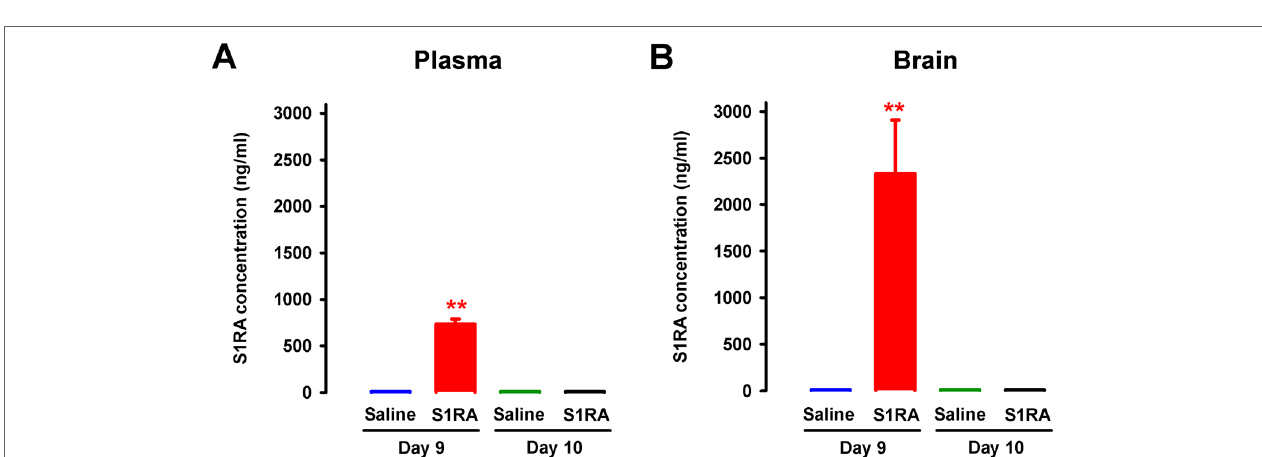
FIGURE 12 | Concentrations of S1RA in plasma and brain tissue after its repeated administration in female WT. The levels of S1RA were measured by high- performance liquid chromatography–triple quadrupole mass spectrometry (HPLC-MS/MS) in plasma (A) and brain homogenates (B) . Mice were treated from day 0 to day 9 twice daily with either saline or S1RA (25 mg/kg, i.p.). Plasma and brain samples were obtained on day 9 (30 min after S1RA or saline administration) and day 10 (12 h after S1RA or saline administration). Each bar and vertical line represent the mean ± SEM of the values obtained in five to six animals (A and B) . Statistically significant differences between the levels 30 min after S1RA administration and the rest of the experimental groups: ** P < 0.01 (two-way ANOVA followed by Bonferroni